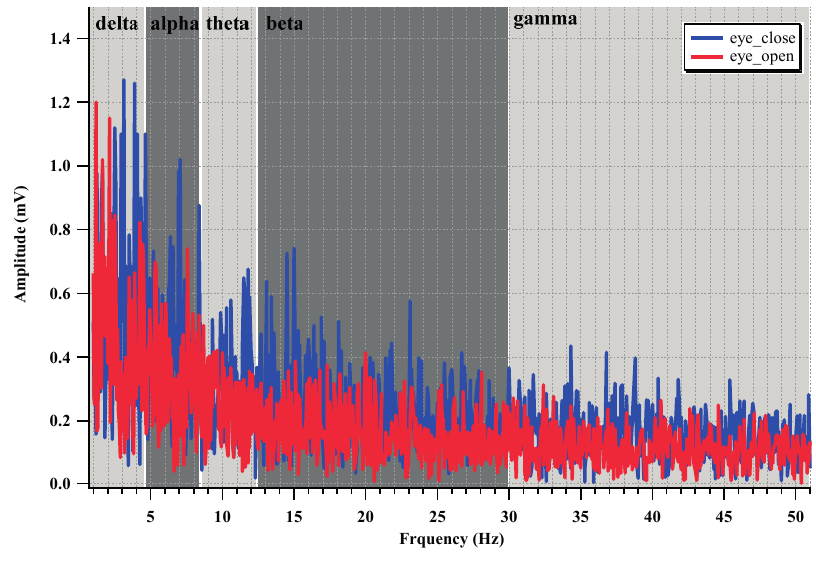
Figure 23. Measured EEG